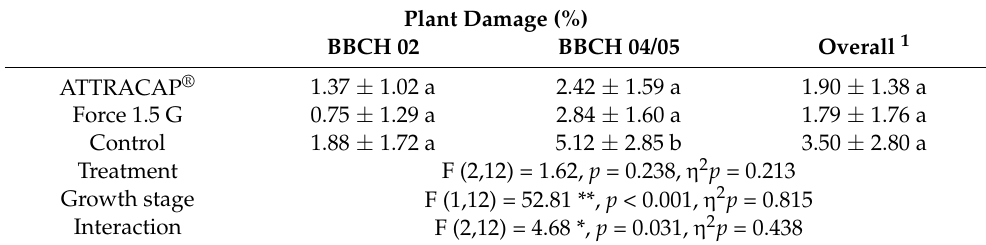
Table 2. Plant damage depending on the insecticidal treatment in